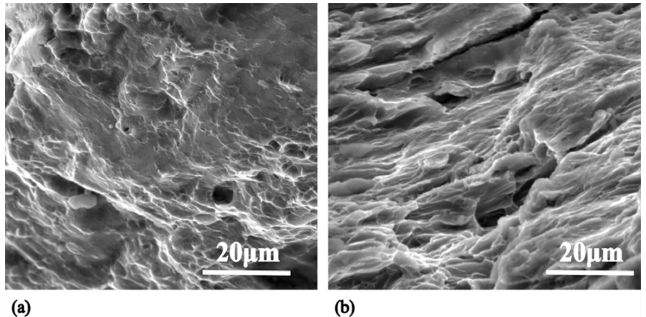
Figure 7. The fracture surfaces of the edge crack for plates rolled at different temperatures: ( a ) 150 °C and ( b ) 200 °C.